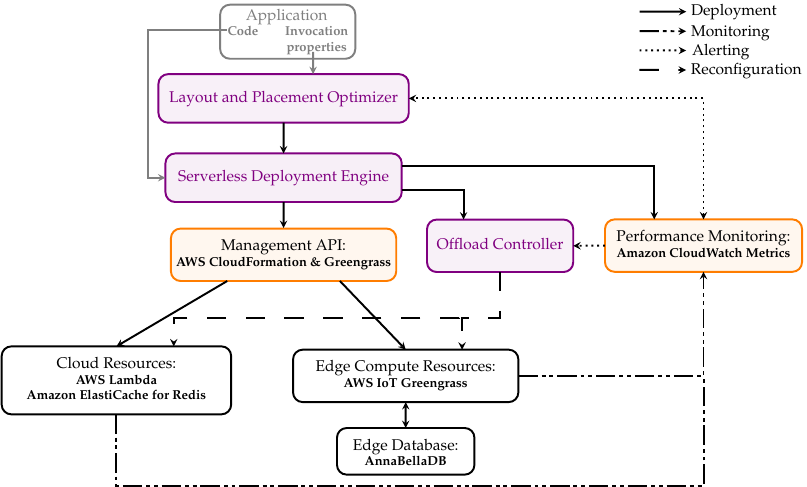
Figure 1. High-level overview of the application layout optimization, deployment and monitoring system with database